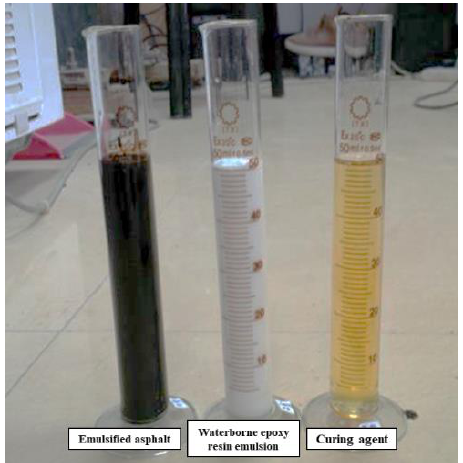
Figure 2. Three components of the epoxy-emulsified